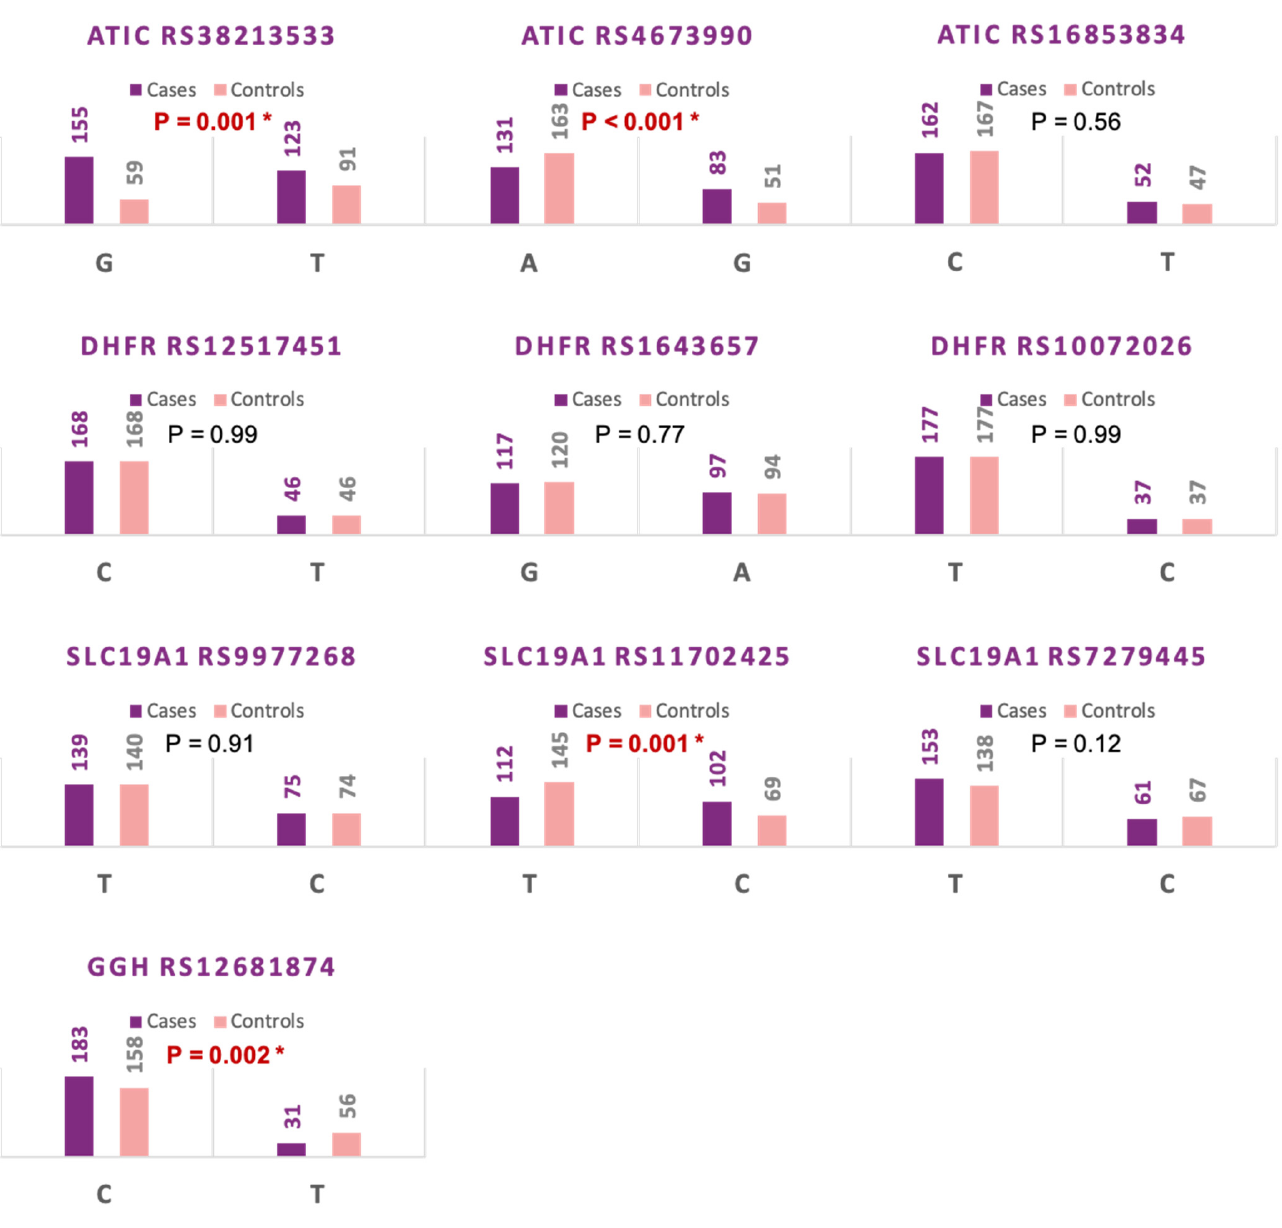
Figure 2. Allele frequencies of methotrexate pathway genes in rheumatoid arthritis versus normal controls. * p -value < 0.05 and statistically significant.